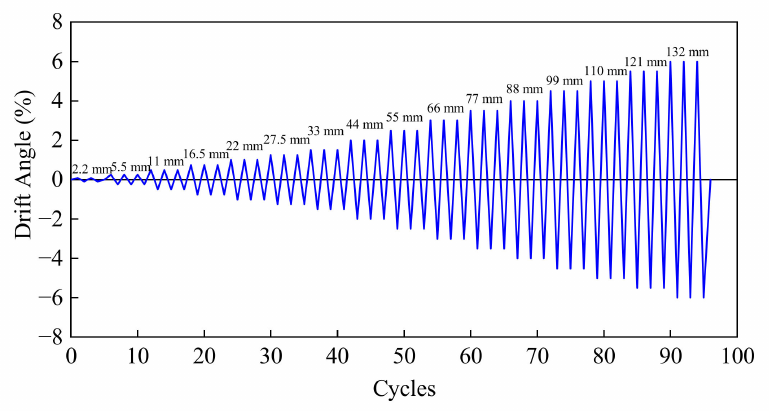
Figure 8. Cyclic loading pattern.